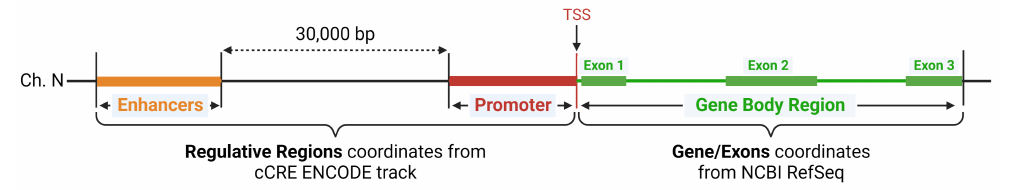
Figure 2. Genomic Model. The genomic model consists of the coordinates of all the genomic regions related to the gene. The gene body region (green) comes from the NCBI RefSeq Genes annotations. The regulative regions, i.e., Promoter (in red) and Enhancers (in orange) come from the cCREs ENCODE